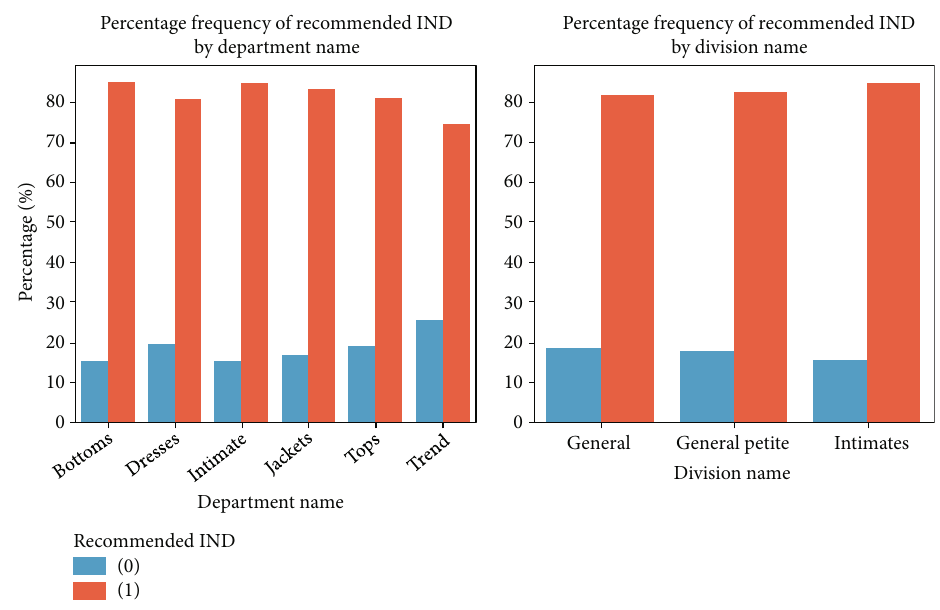
Figure 14: Percentage of recommendation metrics per analysis by division and department.